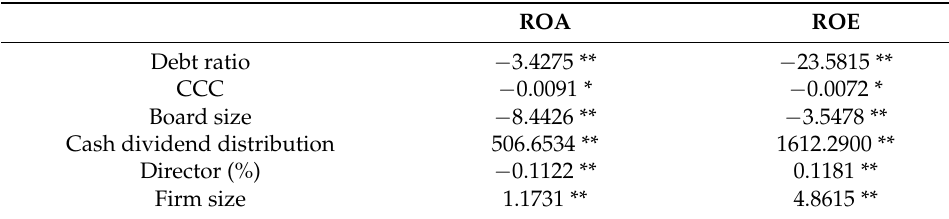
Table 2. Regression results of all